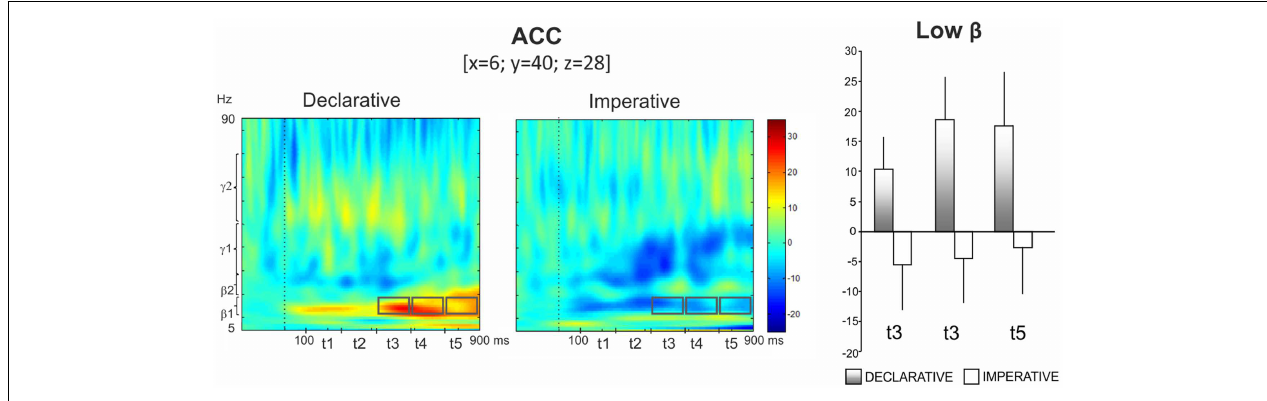
Bar plots show averageTFR values within gray boxes together with their standard deviations (right). Significant differences as revealed by